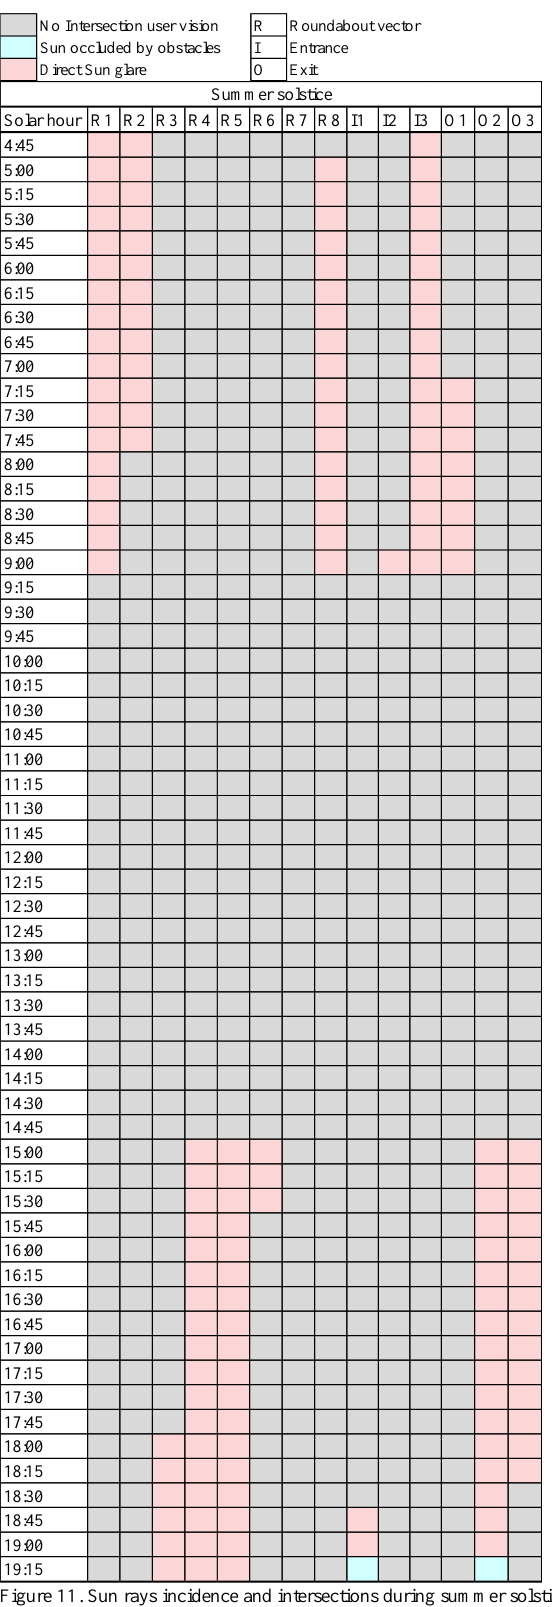
Figure 11. Sun rays incidence and intersections during summer solstice All experiments were executed on Intel® Core™ i7 CPU 3.4GHz with 16GB RAM using Python. The total time processing considering one season and analysing all driver bearing vector was 6’ 48’’. The time processing detail is shown in Table 2.